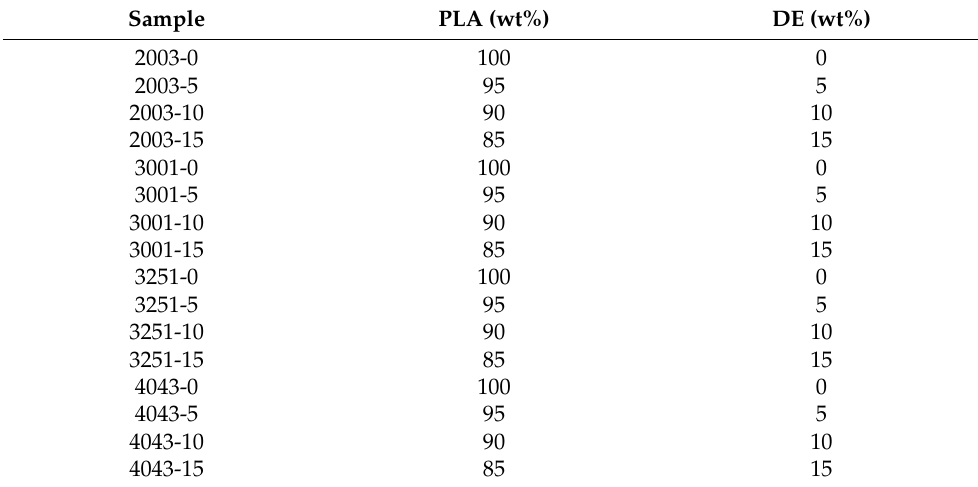
Table 1. The codes and composition of the prepared composite